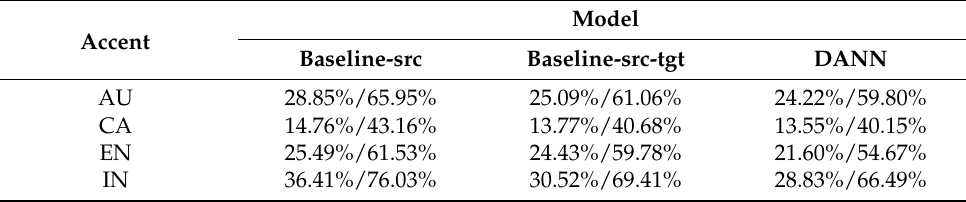
Table 5. Performance (CER/WER) comparison between the baseline and DANN models. Accent